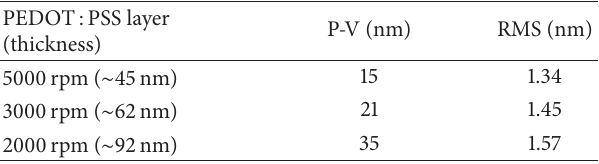
BM Table2:SurfaceroughnessparametersobtainedfromAFManalysis 71 for different thickness of PEDOT: PSS